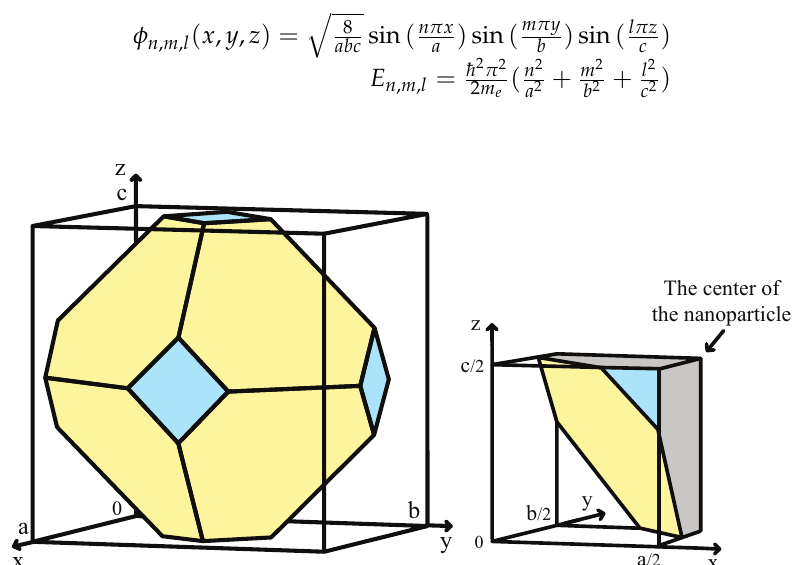
Figure 7. ( Left ): The polyhedron that forms the boundary of the nanoparticle enclosed in the simulated box with dimensions ( a , b , c ); ( Right ): The octant used to calculate the potential integral. Grey color represents the inner part of the